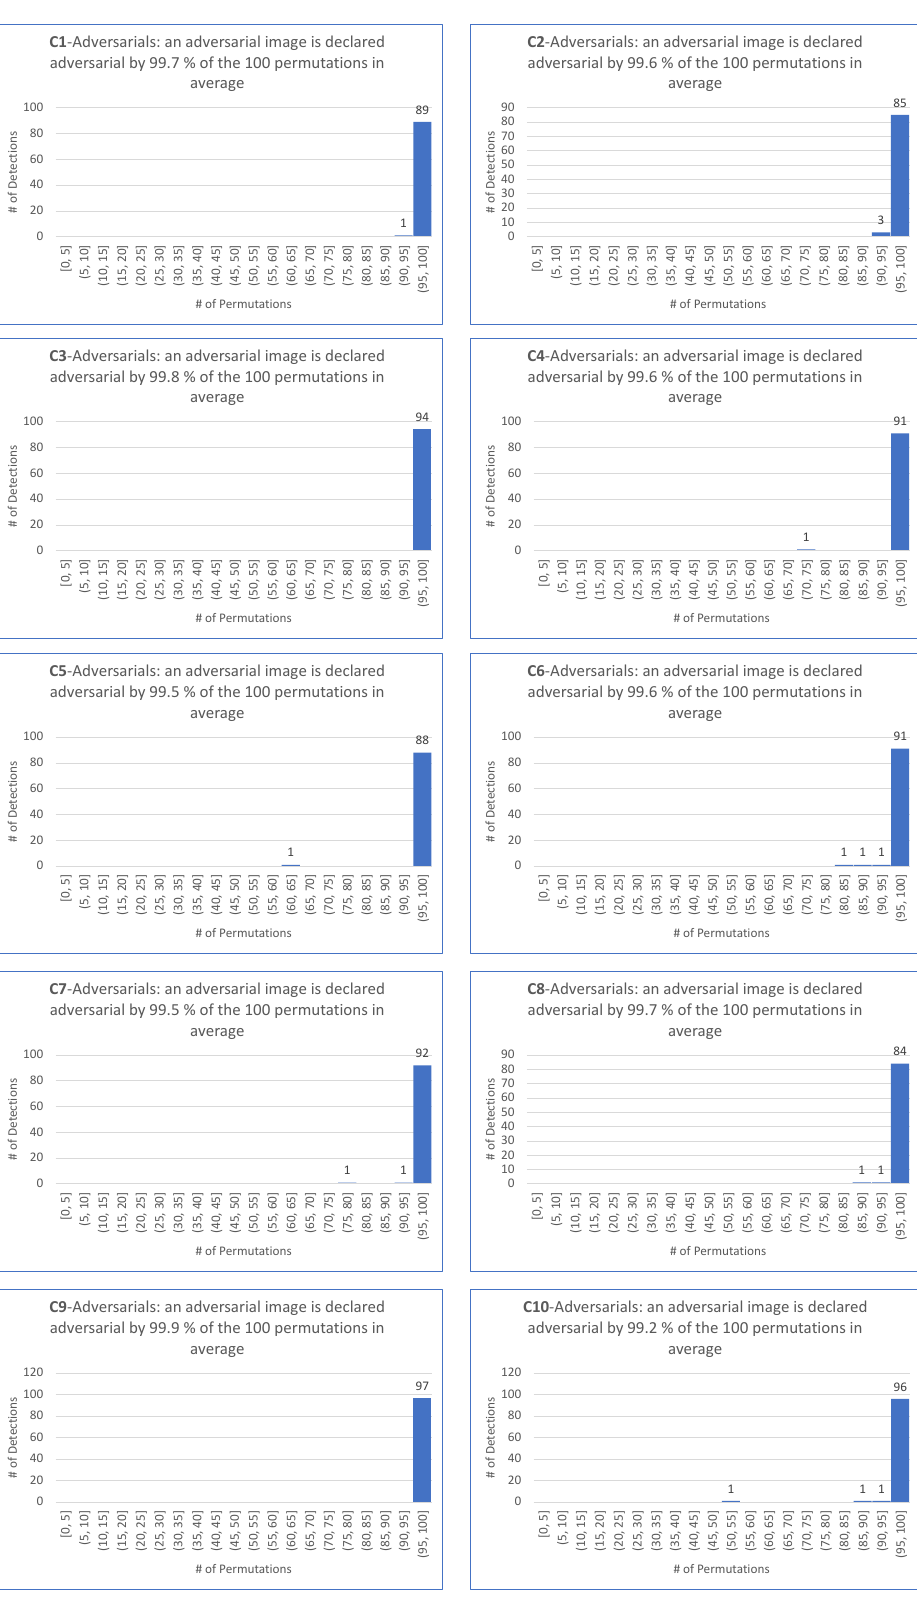
Figure A6. ShuffleDetect results for adversarial images generated by the PGD L2-targeted attack on C = C for 1 ≤ k ≤ 10 over 100